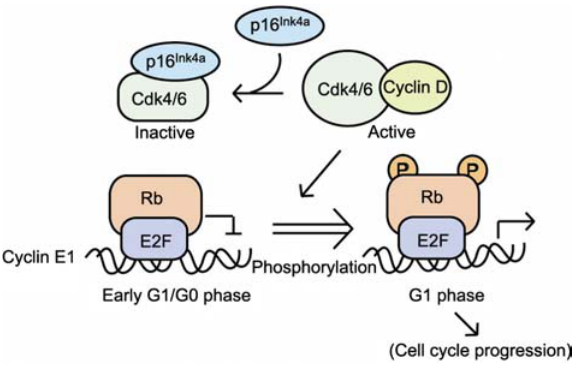
Figure 2 The p16 Ink4a -pRb